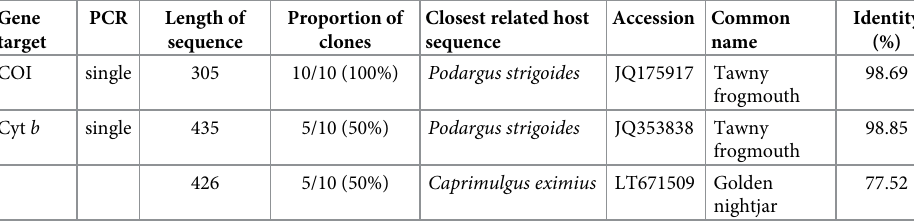
Table 4. Blood meal analysis for mosquito